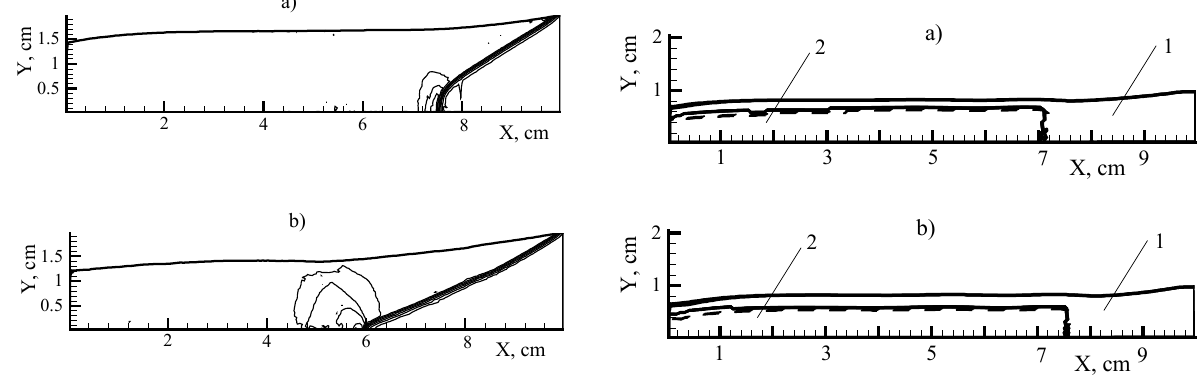
Figure 14: Compacted and destructed regions for two values  cm: a) cylindrical e of external pressure, = 0.05 P Mbar (a) and = 0.075 P Mbar (b). The detonation velocity is = 7 D km/s. The solid and dashed lines show the calculation data for the explosive  cm and = 5  cm. thicknesses = 3 e e